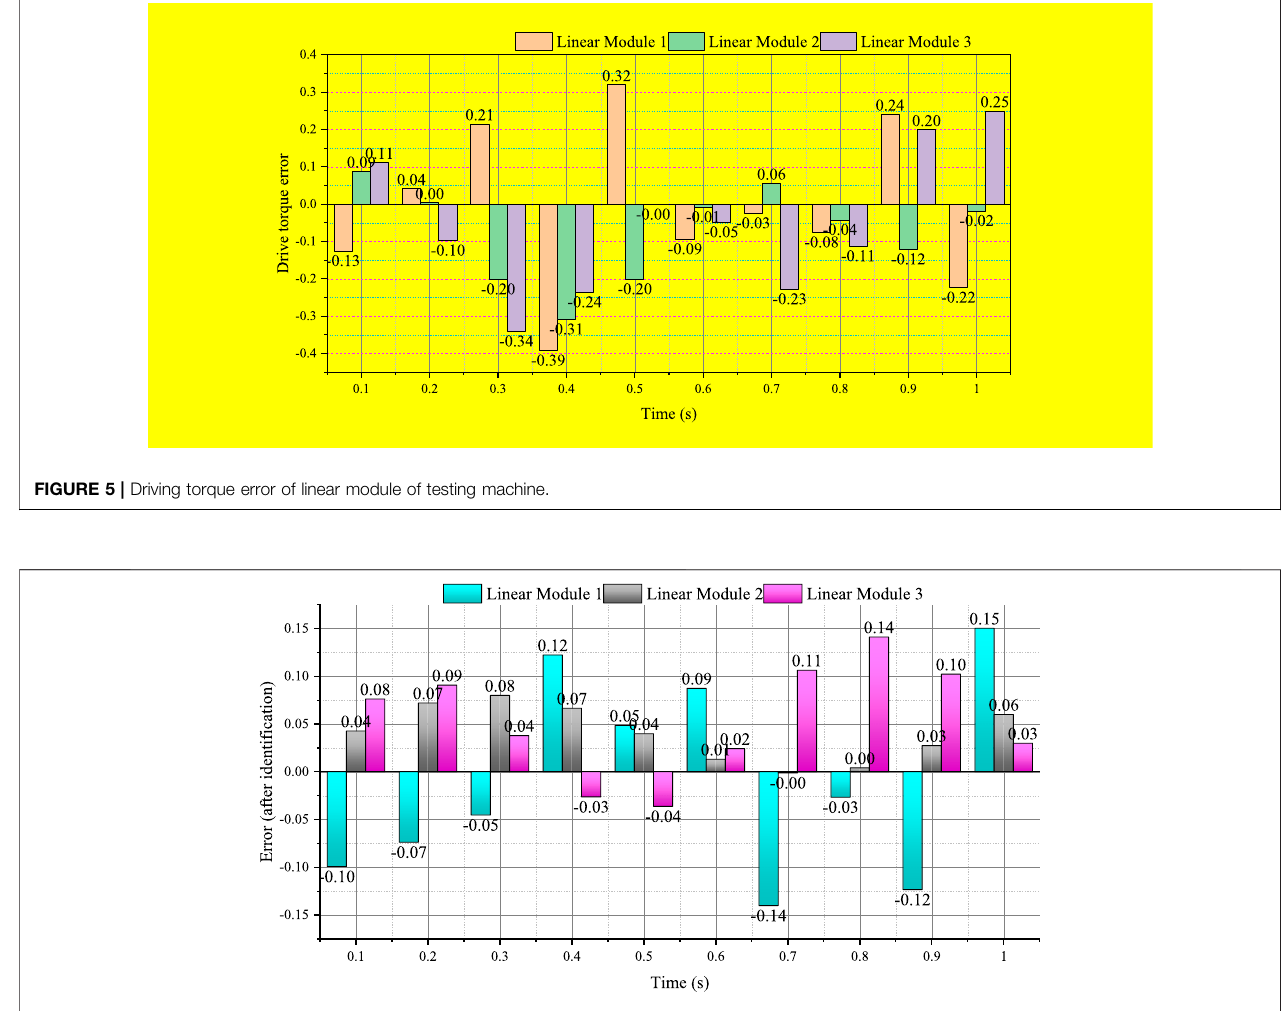
Frontiers in Bioengineering and Biotechnology |